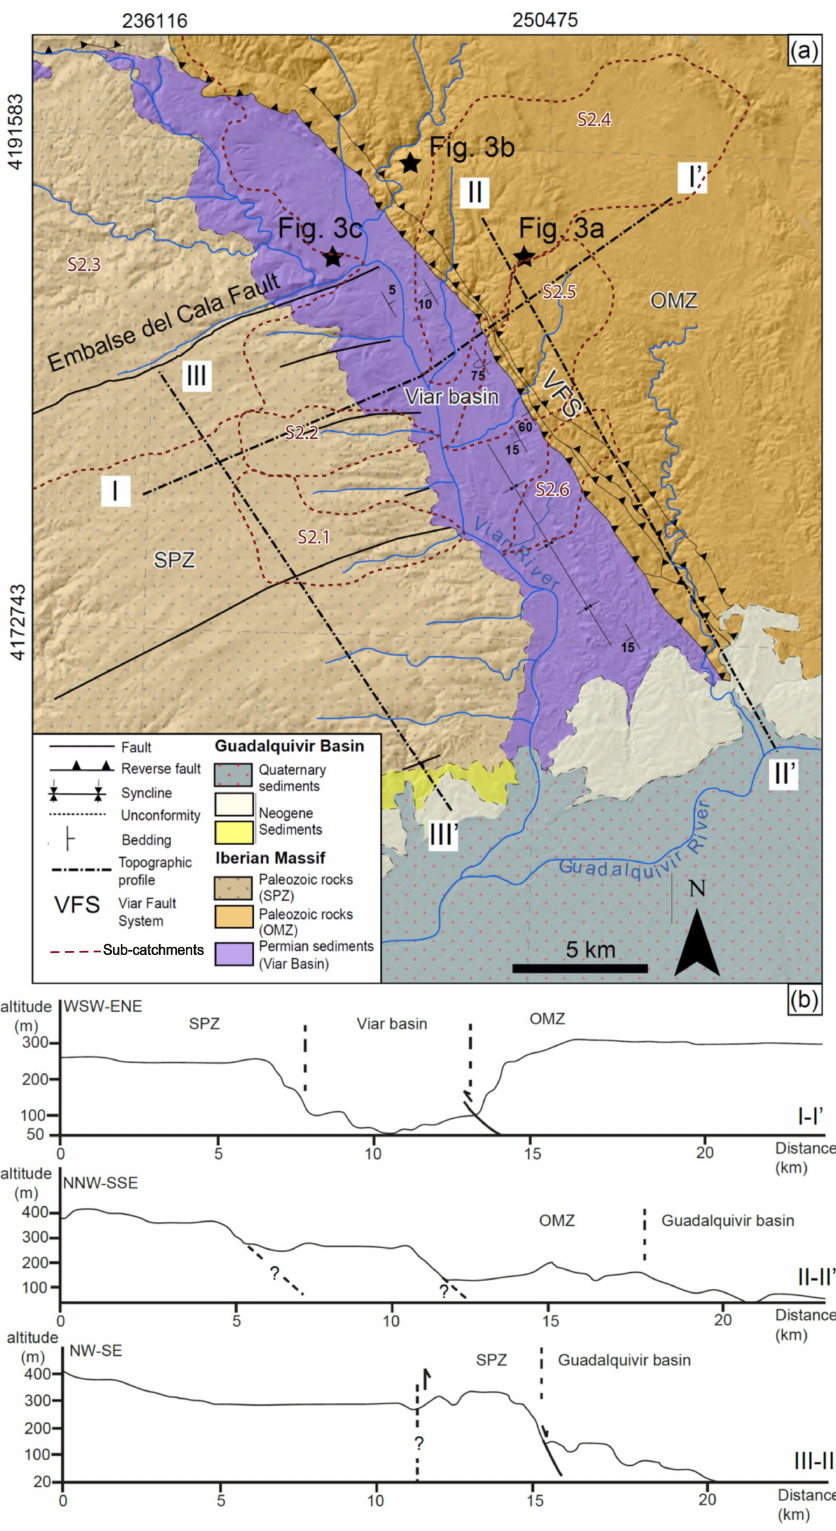
Figure 2. (a) Simplified geological/hillshade relief map of the Permian Viar basin (see the location in Fig. 1b). VFS is the Viar fault system, OMZ is the Ossa-Morena zone, and SPZ is the south Portuguese zone. S2.1 to S2.6 (dashed red lines) are the analysed sub-catchments of S2. (b) Topographic profiles across both the Viar basin (I–I’) and the Iberian Massif/Guadalquivir basin boundary (II–II’ and III–III’). The dashed line indicates the position of faults inferred from the observed paleo-peneplain downthrow. Altitude base and reference system are as in Fig.